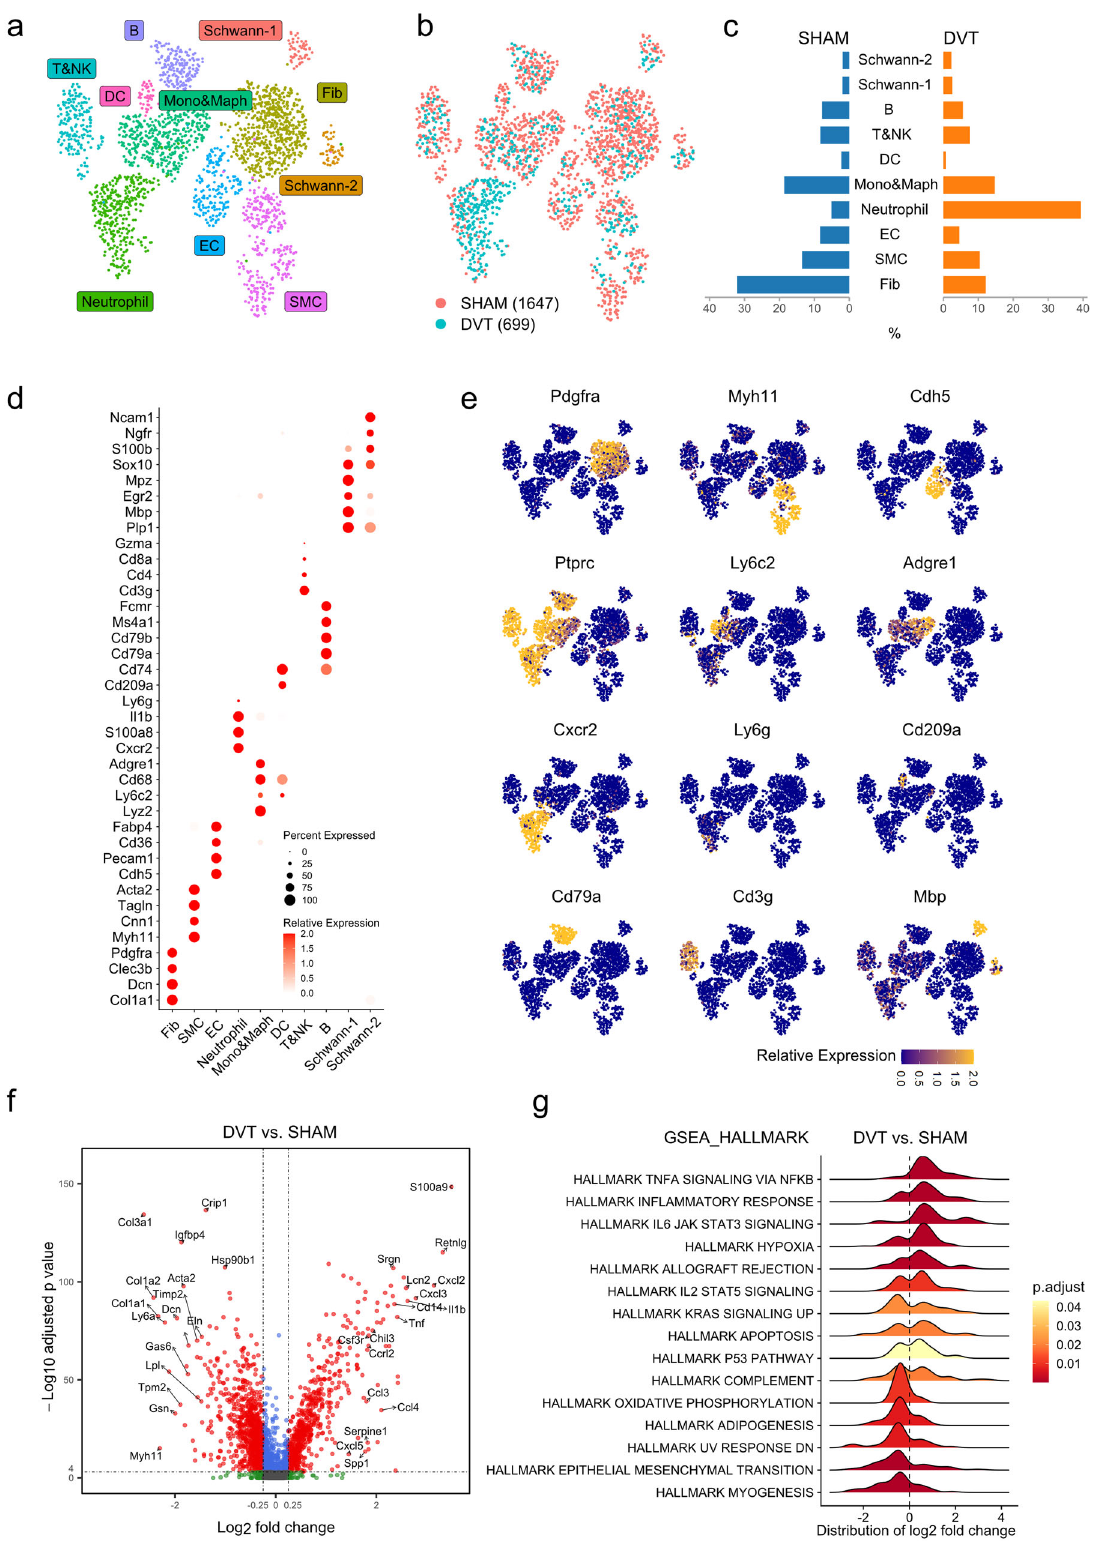
Fig. 1 Identi fi cation of cell populations in mouse deep vein thrombosis (DVT) model. 8 to 12-week-old male C57BL6/J mice were subjected to the inferior vena cava (IVC) ligation model of DVT. IVC was collected 24 h after ligation. IVC from 8 sham or 5 DVT-bearing mice was pooled as one sample in each group. a Uniform manifold approximation and projection (UMAP) plot of cell clusters presented in mouse IVCs (sham and DVT data combined). b Cell distributions in sham and DVT groups. c Percentages of cell populations in sham and DVT groups. d Expression of canonical cell markers in each cluster. e UMAP plots of cell markers in sham and DVT data combined. f Volcano plot of differentially expressed genes (DEGs) in DVT versus sham group. g Gene Set Enrichment Analysis (GSEA) of up- and down- regulated gene sets in DVT versus sham group. Hallmark gene sets were used.